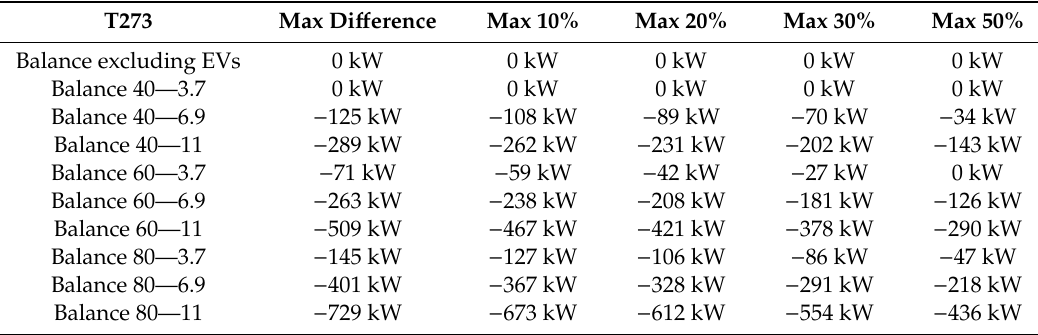
Table 7. E ff ect of flexible demand for Transformer T273.